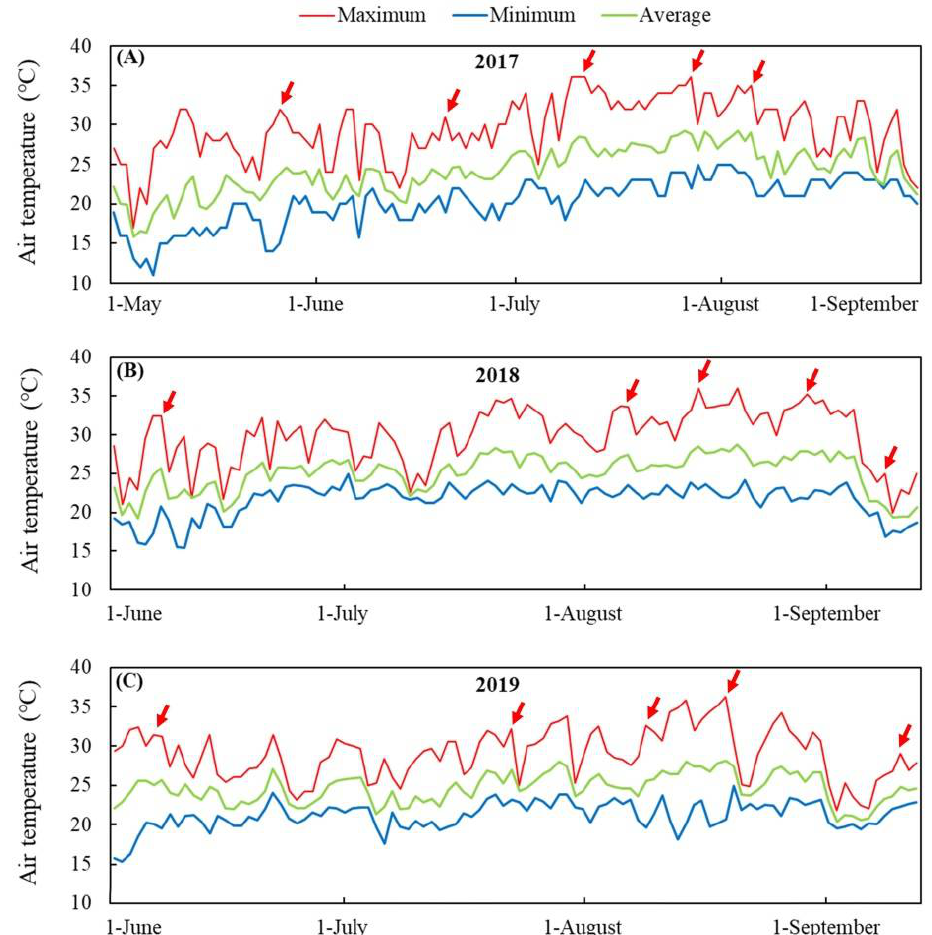
Figure 1. Daily maximum, minimum, and average air temperature in ( A ) 2017, ( B ) 2018, and ( C ) 2019 in the Research Farm of Sichuan Agricultural University (Chongzhou, Sichuan, China, east longitude 103°07′–103°49′ and north latitude 30°30′–30°53′). Red arrows indicate sampling dates.